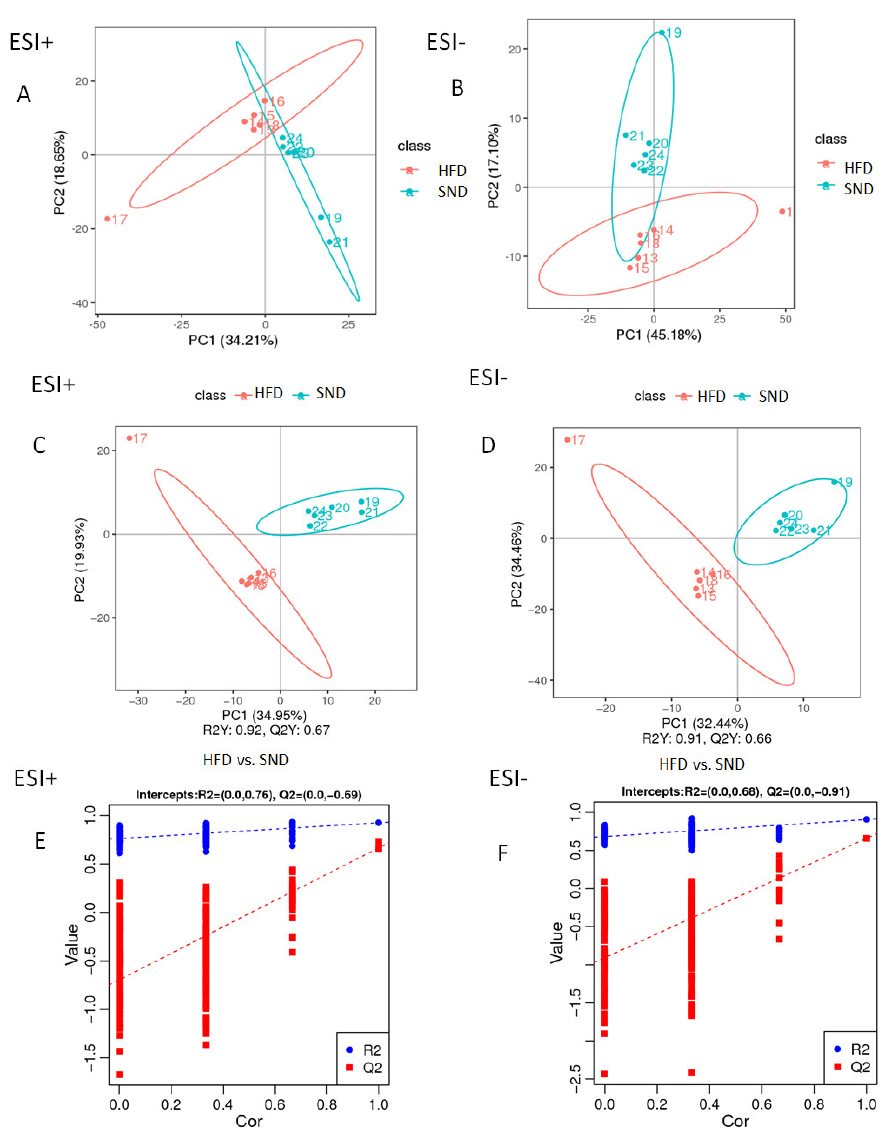
Figure 2. Quality control of metabolomics data. PCA score plots for SND ( n = 6) and HFD ( n = 6) groups in the positive ( A ) and negative ( B ) ion modes. PLS-DA score plots for SND ( n = 6) and HFD ( n = 6) groups in the positive ( C ) and negative ( D ) ion modes. Permutation tests from PLS-DA models for SND ( n = 6) and HFD ( n = 6) groups in the positive ( E ) and negative ( F ) ion modes.